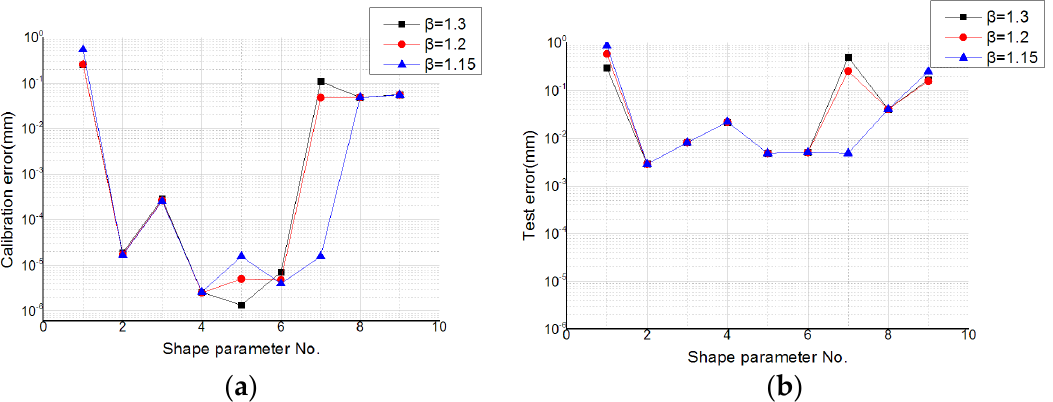
Figure 12. Calibration error and test error of the Gaussian function with different values of the shape